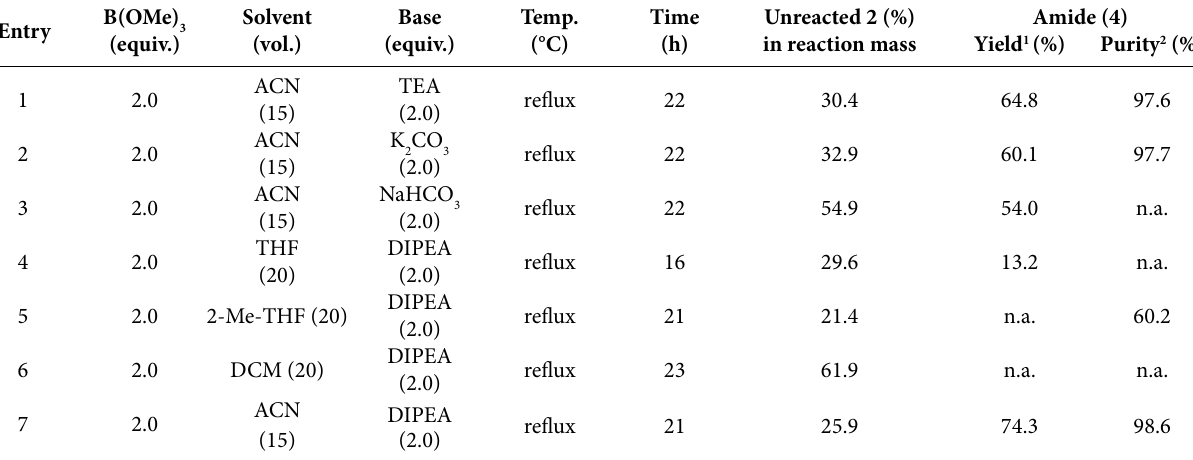
Table 1. Screening of coupling agent, solvent and base for amidation of 2 and 3 .